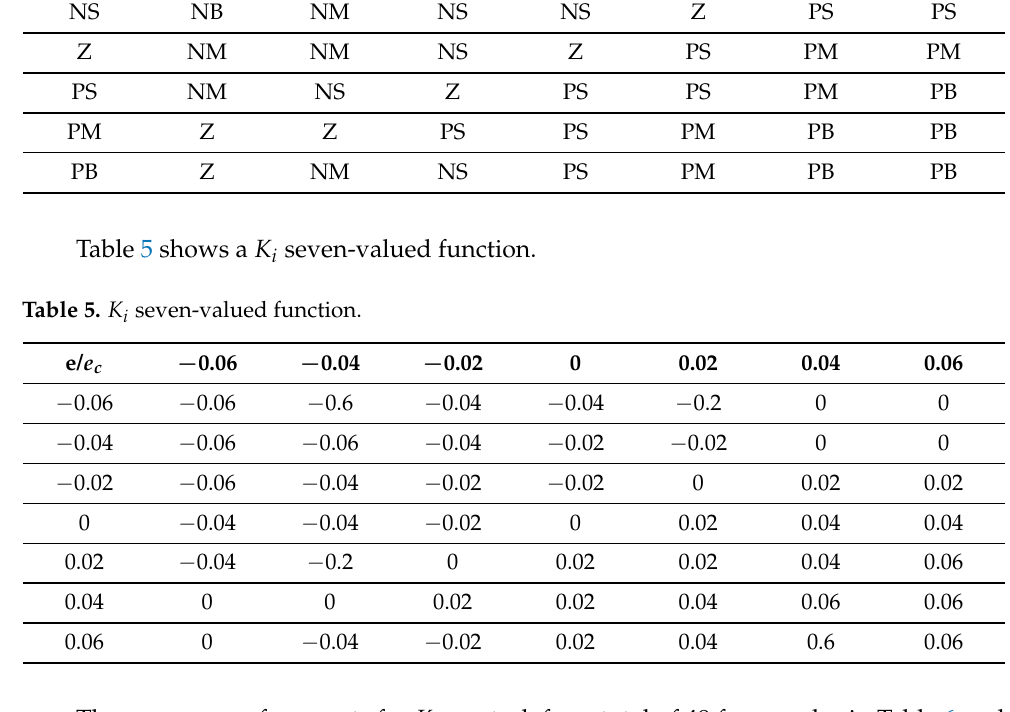
these rules in the table are transferred into numbers as in Table